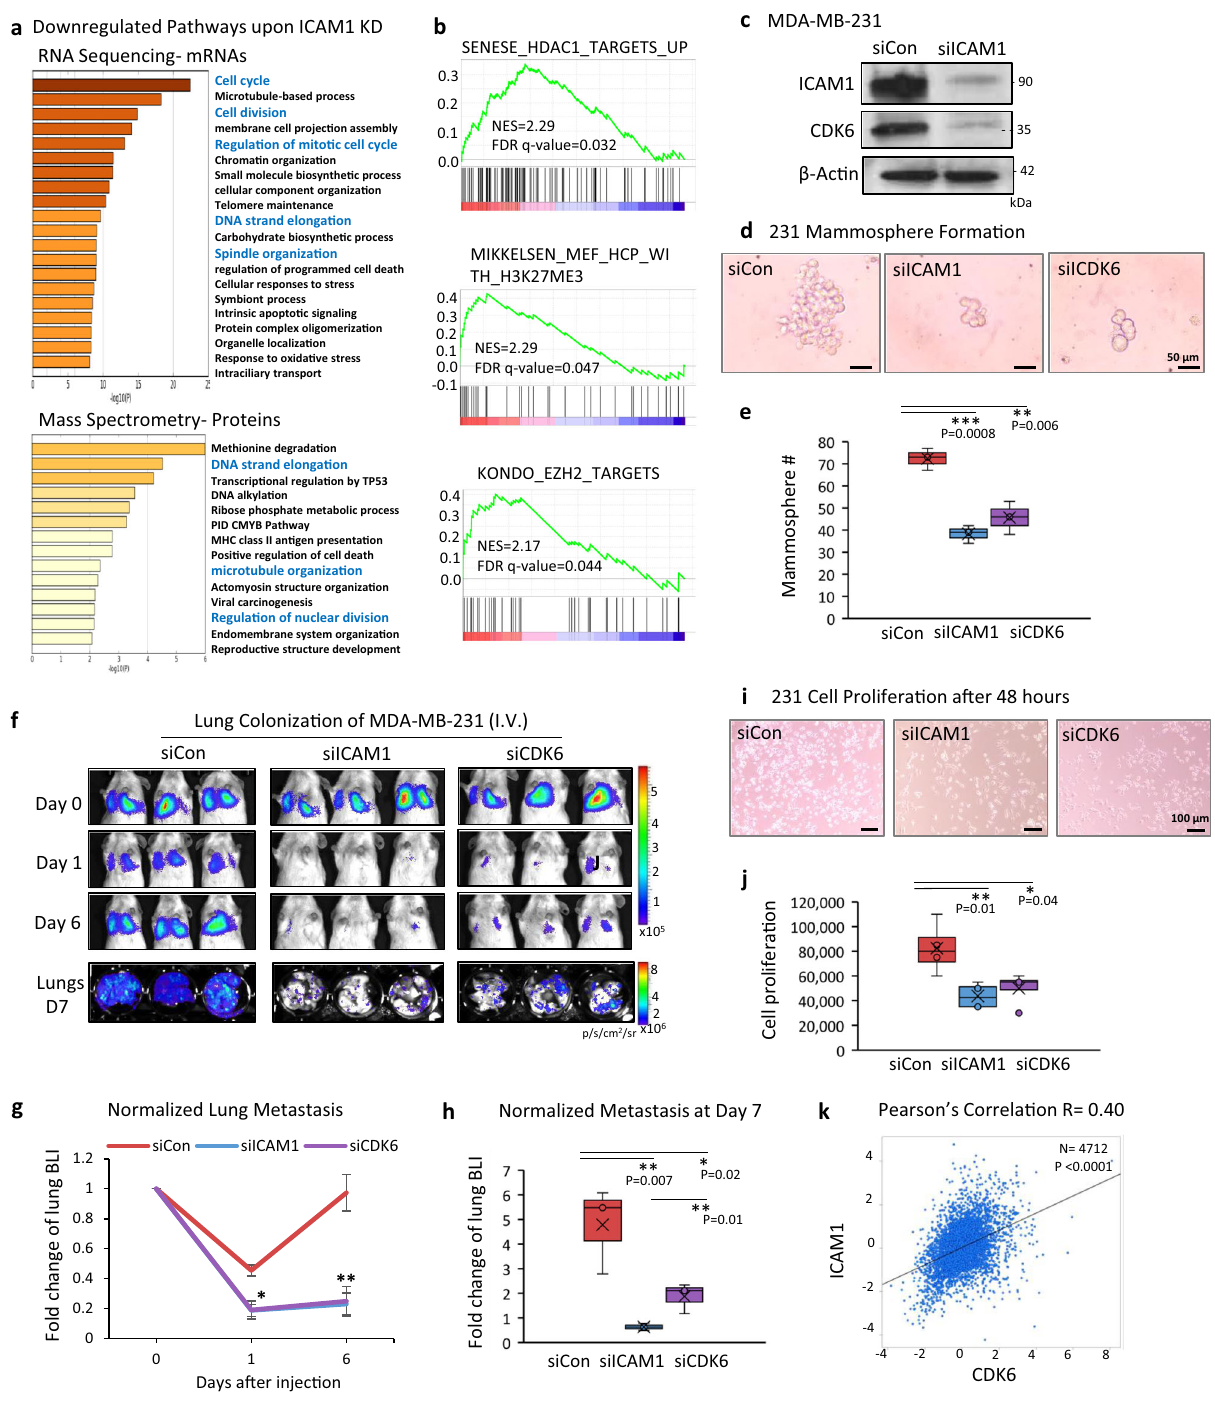
lymphocytes and macrophages 23 – 26 . We fi rst measured the ICAM1 and its integrin ligands by fl ow cytometry in endothelial cells and found an absence of the integrin ligand CD18 (part of LFA1 and MAC1) (Supplementary Fig. 10a). Using the transwell insert pre-coated with con fl uent human umbilical vein endothe- lial cells (HUVECs), we added breast tumor cells on top of the endothelial cells in the insert under four different conditions: (i) control siRNA in endothelial cells, (ii) ICAM1 knockdown in endothelial cells alone, (iii) in tumor cells alone, or (iv) in both tumor cells and endothelial cells (Fig. 4a). After 24 h, we observed